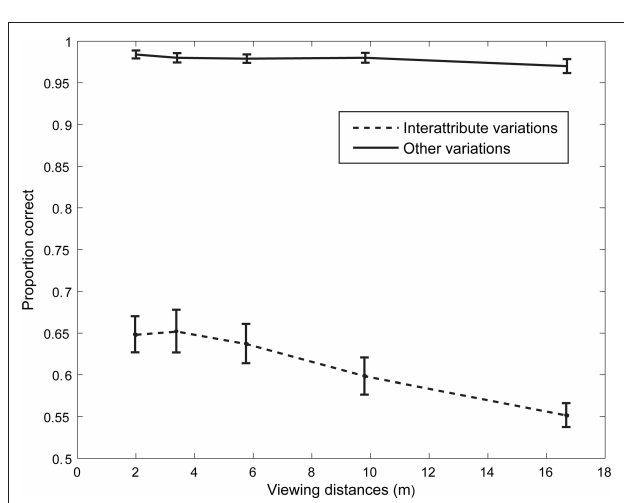
information available. Bottom: In Experiment 2b, we asked the complementary question: Can human observers use real-world cues other than interattribute distances such as attribute shapes and skin properties, at different viewing distances, to resolve an ABX?